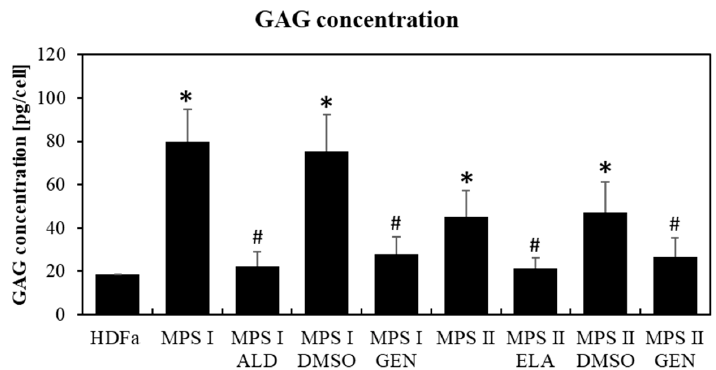
Figure 3. Elevated GAG levels in MPS cells and storage reduction by ERT or SRT. GAG levels in MPS I and MPS II fibroblasts, relative to HDFa control cells, either non-treated or treated with Aldurazyme (ALD, recombinant α -L-iduronidase) at 0.58 mg/mL, Elaprase (ELA, recombinant 2-iduronate sulfatase) at 0.5 mg/mL, DMSO (solvent for genistein) at 0.05%, or genistein (GEN) at 50 µ M for 24 h. Asterisks indicate statistically significant differences (at p < 0.05 in one-way ANOVA) relative to HDFa cells, and hashtags indicate statistically significant differences (at p < 0.05 in two-way ANOVA and post hoc Tukey’s test) relative to non-treated MPS I or MPS II fibroblasts.